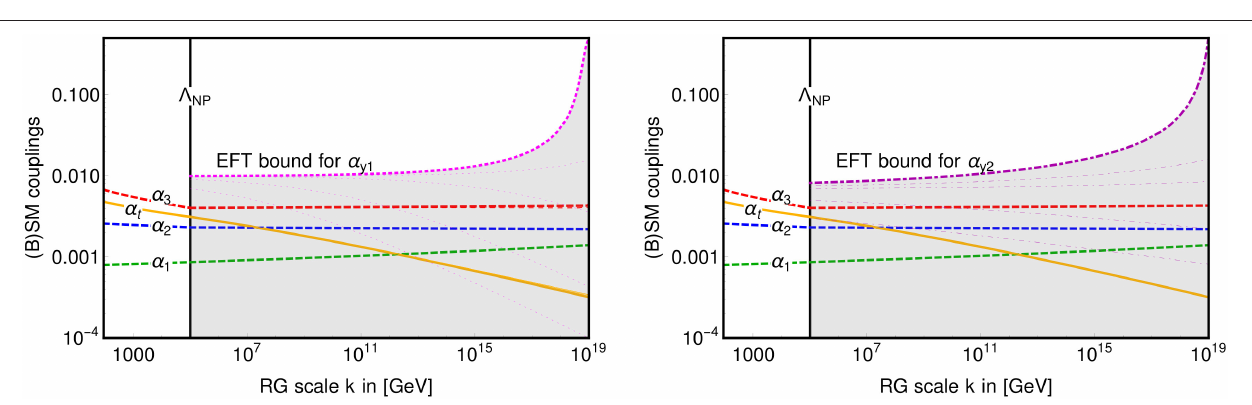
FIGURE 6 | Partial predictivity for the BSM theory identified in Equation (16). The plots show RG trajectories that match the observed values of SM couplings in the heavy-top limit, i.e., α 1 , α 2 , α 3 (dashed), and α t (continuous). At energies below (above) 3 NP , the BSM degrees of freedom decouple (are active). The BSM RG flow focuses arbitrary perturbative initial conditions for the BSM Yukawa couplings α y We also indicate (thin lines) several trajectories to exemplify the behavior of different RG trajectories within the conformal